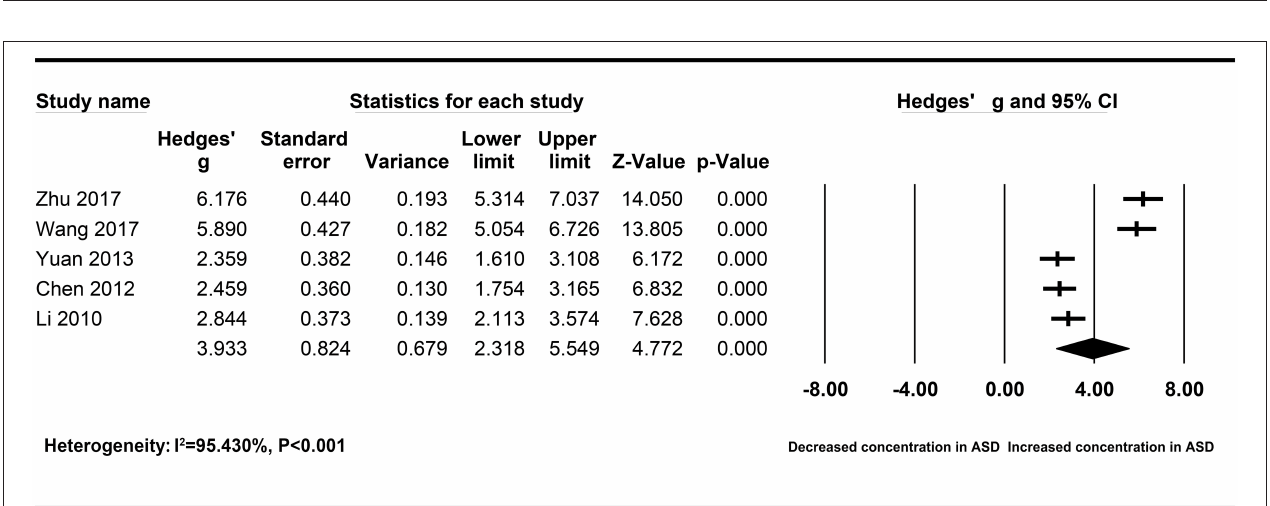
FIGURE 3 | Forest plot for the random-effect meta-analysis of the serum subgroup.